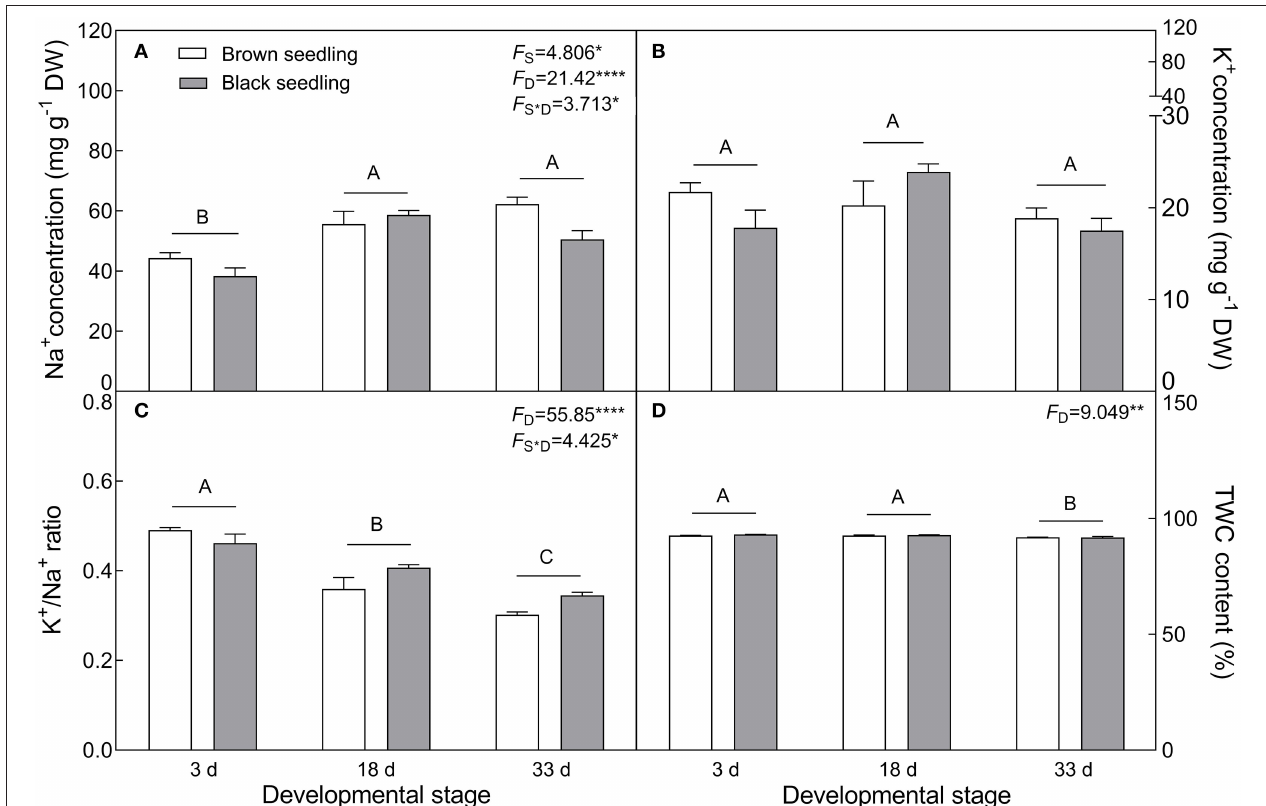
FIGURE 4 | Changes in Na + , K + and tissue water content (TWC) during seedling development. (A) Na + ; (B) K + ; (C) K + /Na + ratio; (D) TWC. 3 d, 18 d, and 33 d: represent 3, 18, 33 days after seedling emergence, respectively. F -values are given when significance levels are reached (the subscript “D” represents “development”; “S”, “seed type”; * P < 0.05, ** P < 0.01; **** P < 0.0001). Bars with different uppercase letters indicate significant differences ( P < 0.05) according to Tukey’s test. Values are means ± SE of four replicates. The Y-axis scale of TWC was adjusted to 150% to make visible of the difference comparison.